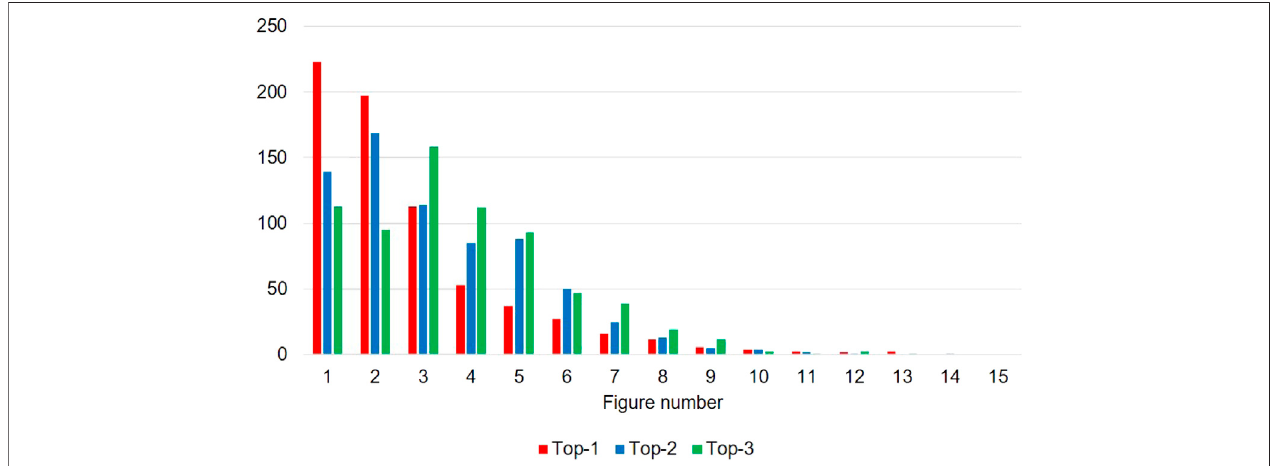
FIGURE 5 | Histogram of fi gure numbers annotated as top-3 fi gure in our proposed CS data set.